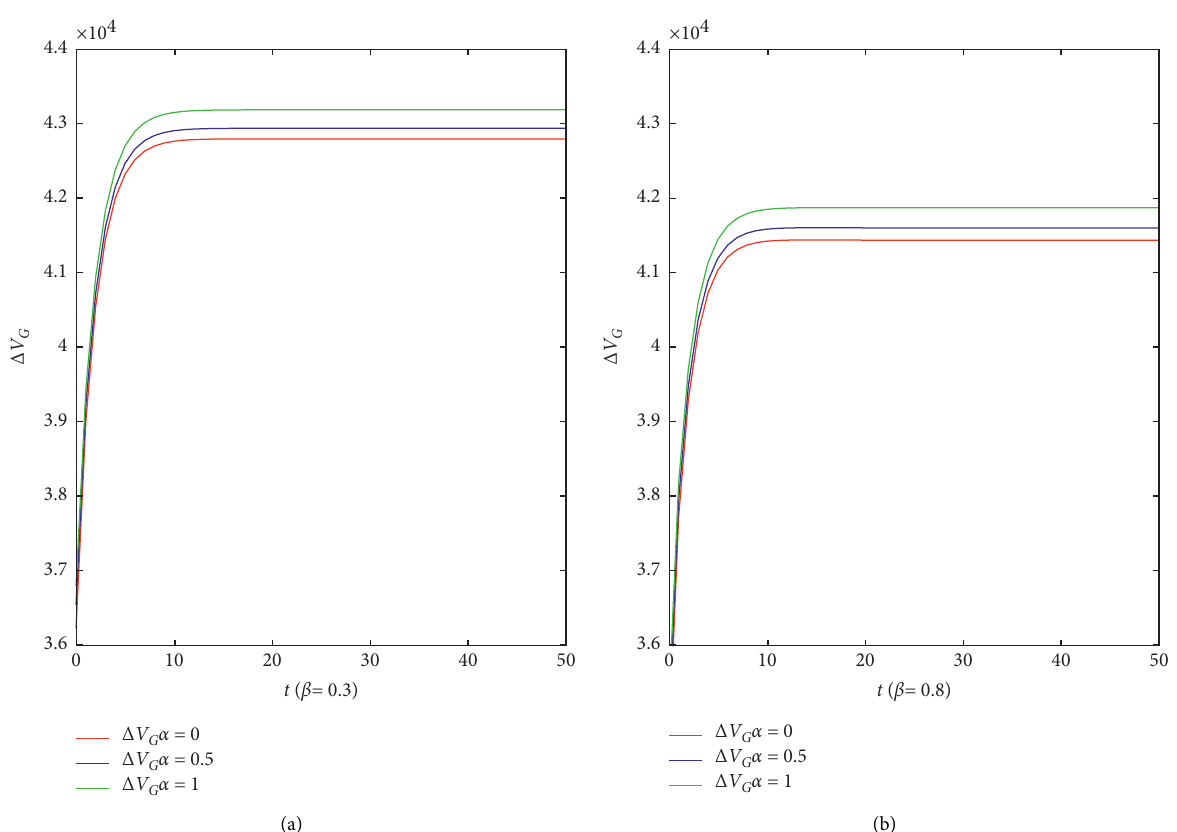
Figure 8: (a) Trajectories of Δ V